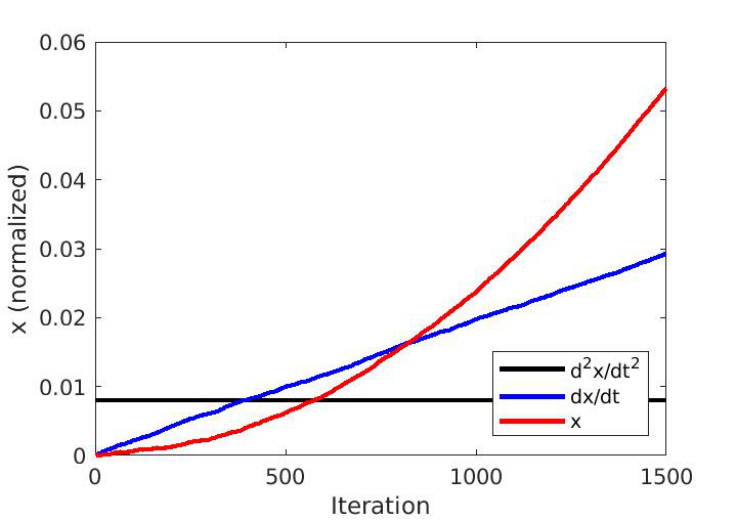
Figure 5. Output of the scheme in Figure 4, showing x , ˙ x and ¨ x . The values of the initial conditions are k 2 = 0.08, k 1 = 0.0, k 0 = 0.0, and N acc = 5000, N = 21 bits, providing a timestep ∆ t ≈ 2.384